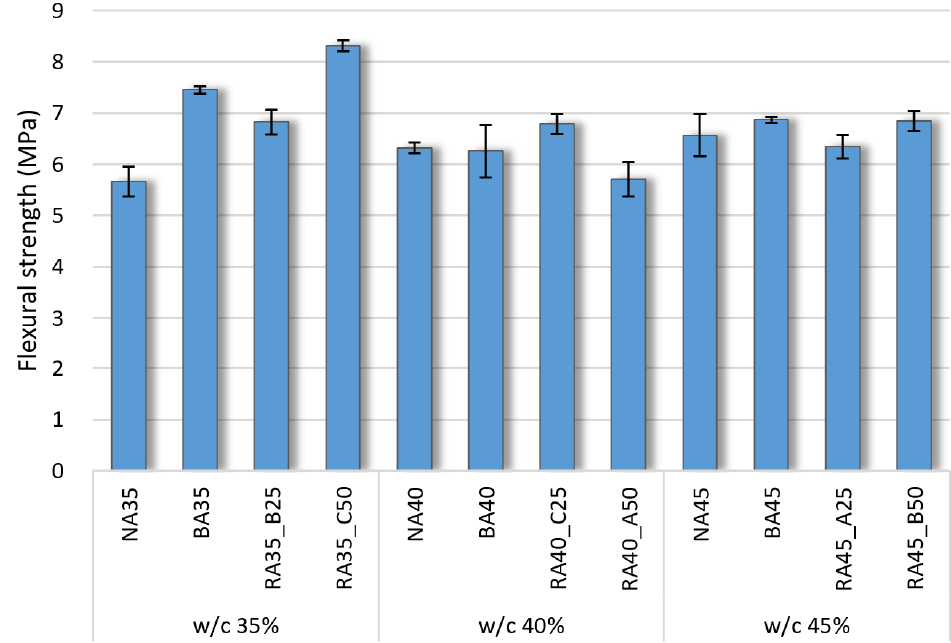
Figure 7. Flexural strength of concrete specimens according to water–cement (w/c) ratio.